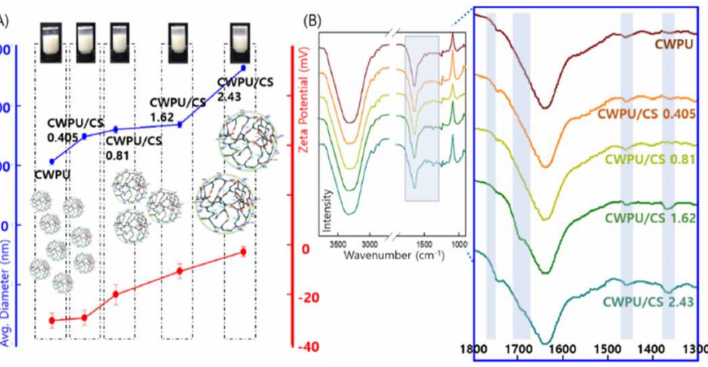
Figure 2. ( A ) Average diameter and Zeta potential, and ( B ) FT-IR spectra of CWPU and CWPU/CS nanocomposites with various CS contents (n ≥